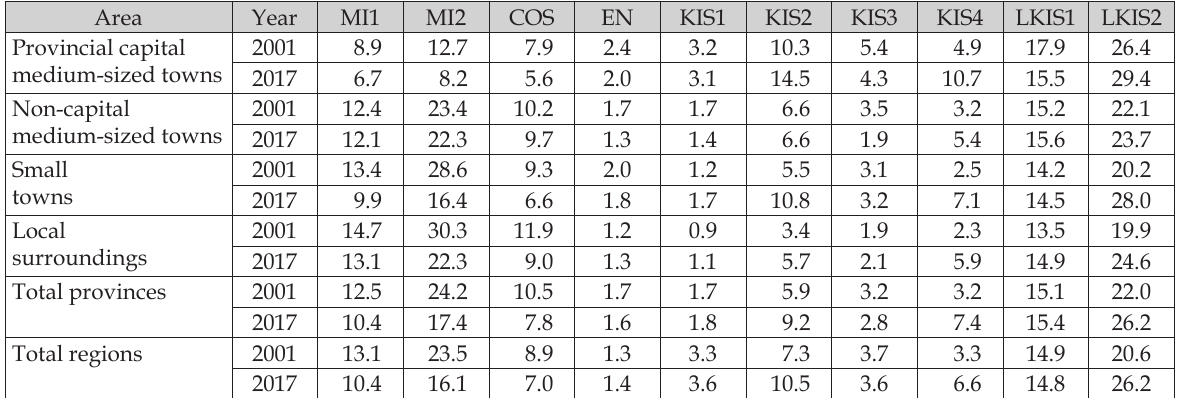
Table 4. Percentage of employees in 10 industries broken down by level of technological and knowledge inten- sity: town and local surroundings (2001, 2017), line = 100%